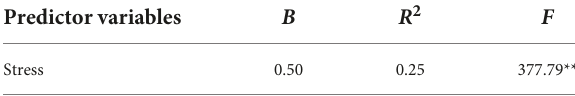
TABLE 1 Demographic variables showing a statistically significant difference on the CSS.